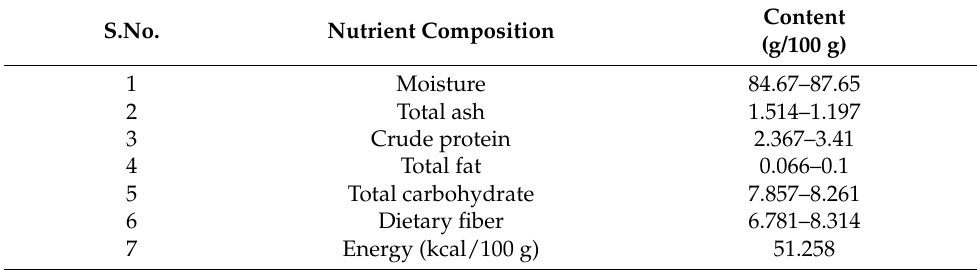
Table 1. Proximate nutrient content of okra pods. S.No.